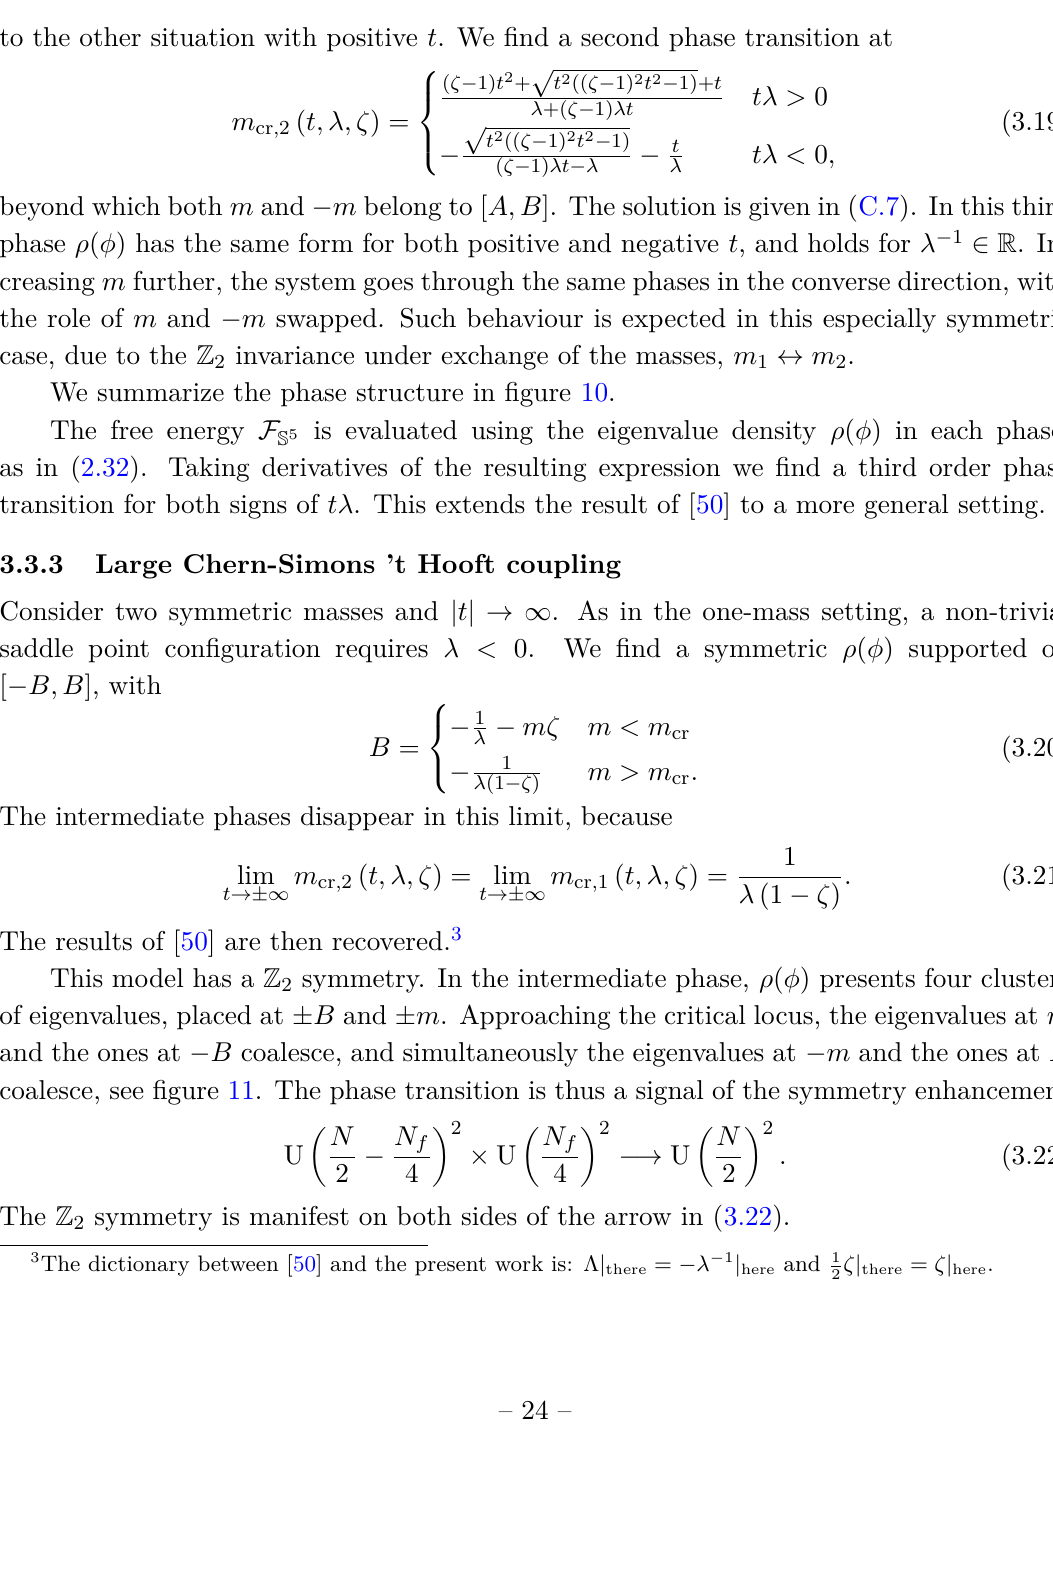
Figure 10 . Phase diagram of the theory with two opposite mass